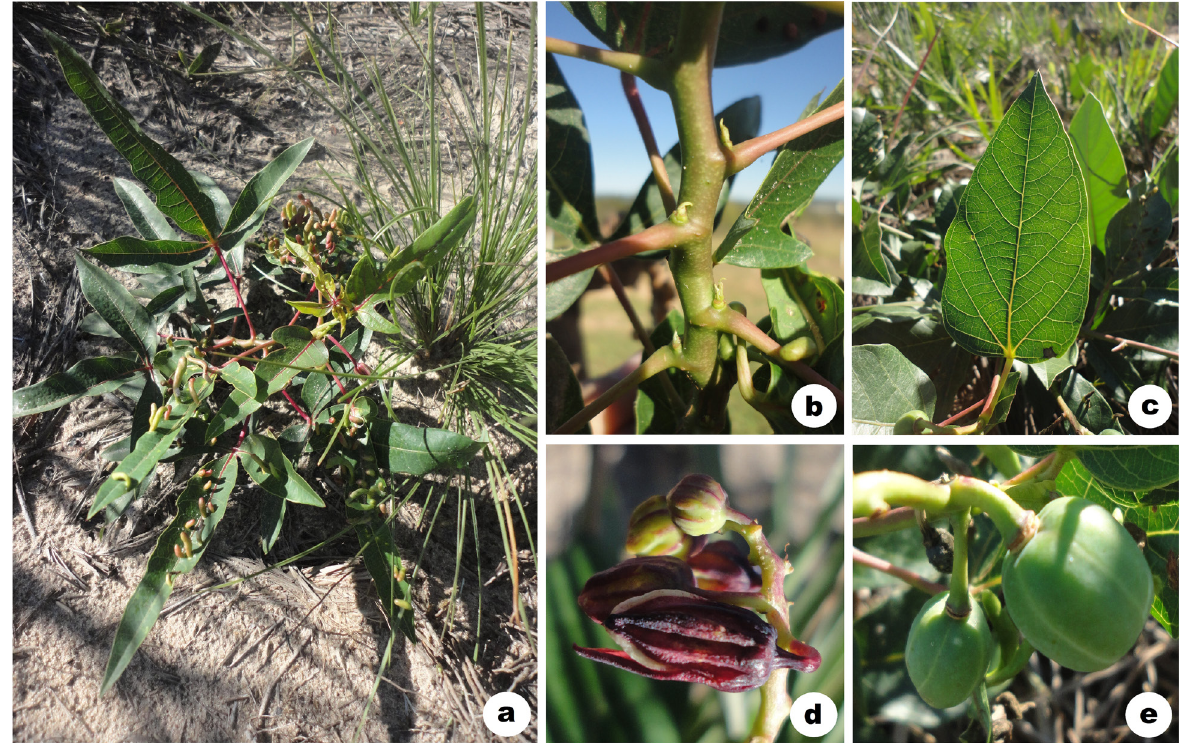
Figure 2. Manihot irregularis M. Martins & Ledo. (a) Habit with leaves variably lobed. (b) Stem and petiole insertion. (c) Unlobed leaf. (d) Staminate bud. (e)